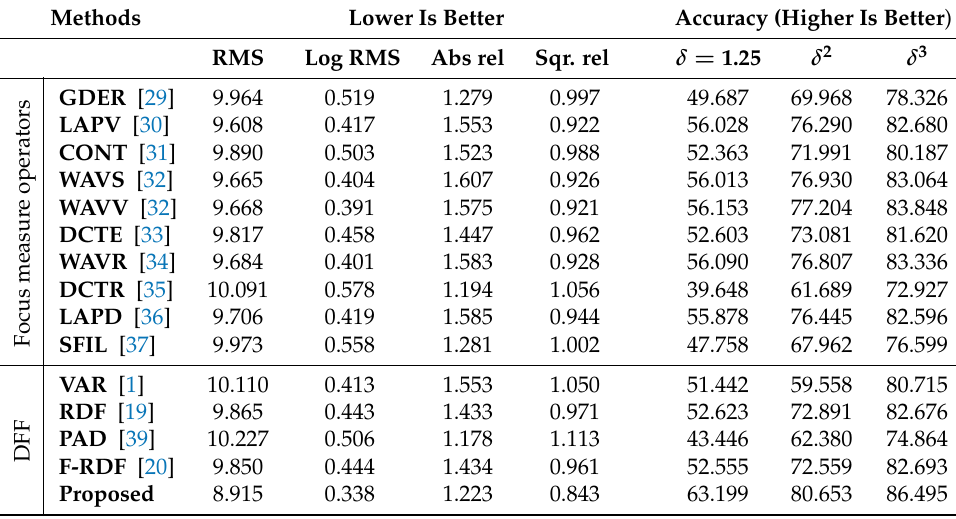
Table 2. Quantitative evaluation on the LFSD dataset